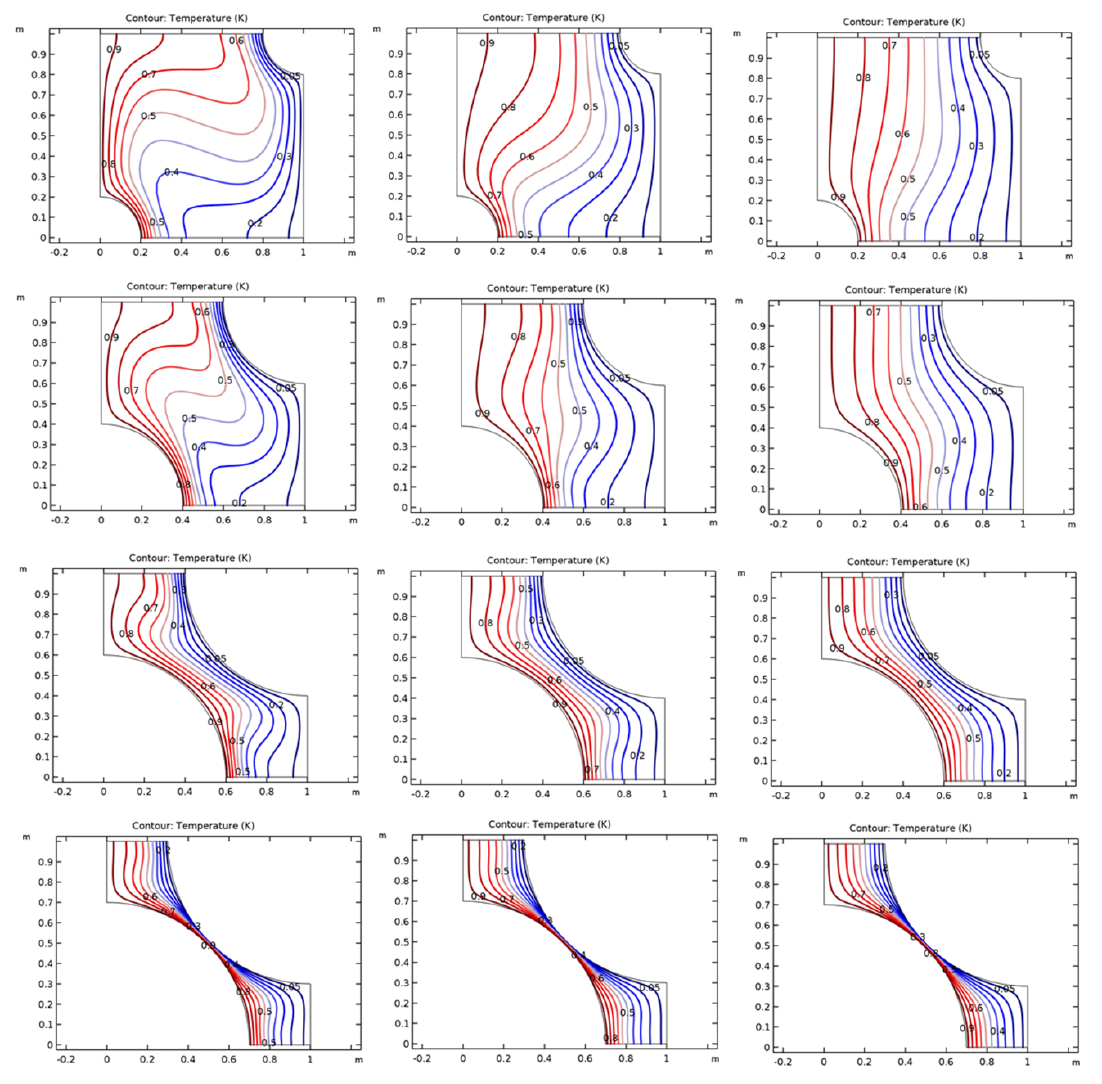
Figure 7. E ff ect of Hartmann number and round corner radius on the isothermal Figure 7. Effect of Hartmann number and round corner radius on the isothermal contours.